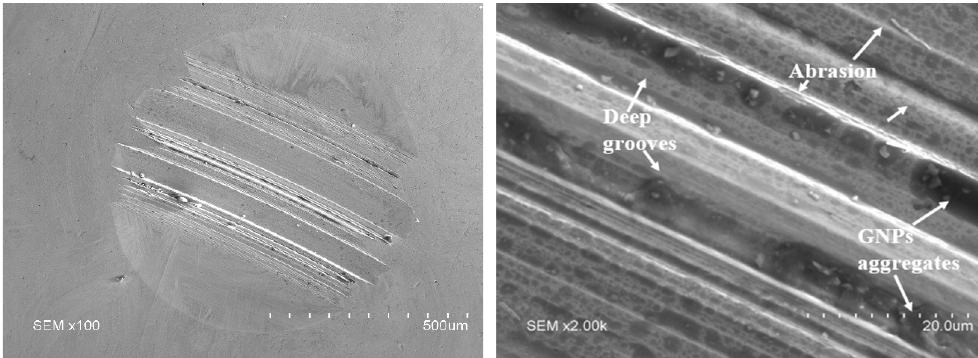
Figure 6. SEM analysis of the worn surfaces on tested balls lubricated with various lubricant samples.